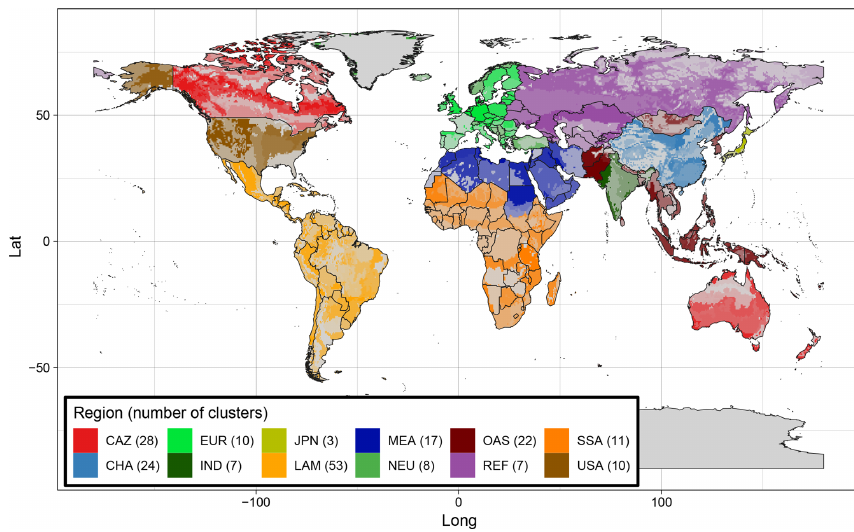
Figure 3. Standard MAgPIE 4 world regions and cluster setup: 12 equally treated world regions with 200 clusters in total.